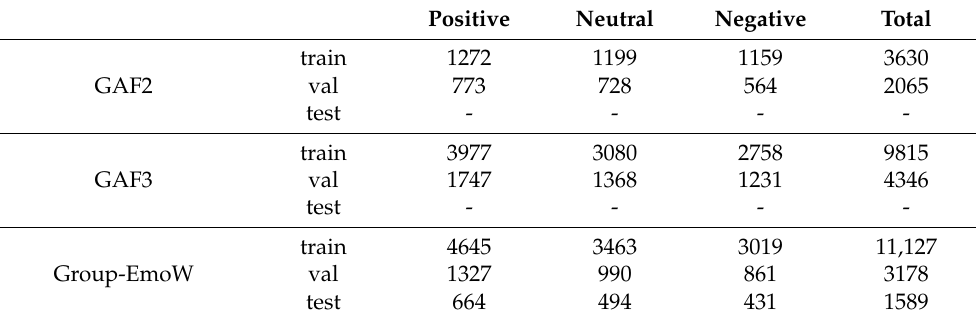
Table 1. Statistics of the three datasets.”-“means the test set is not available. Positive Neutral Negative Total train 1272 1199 1159